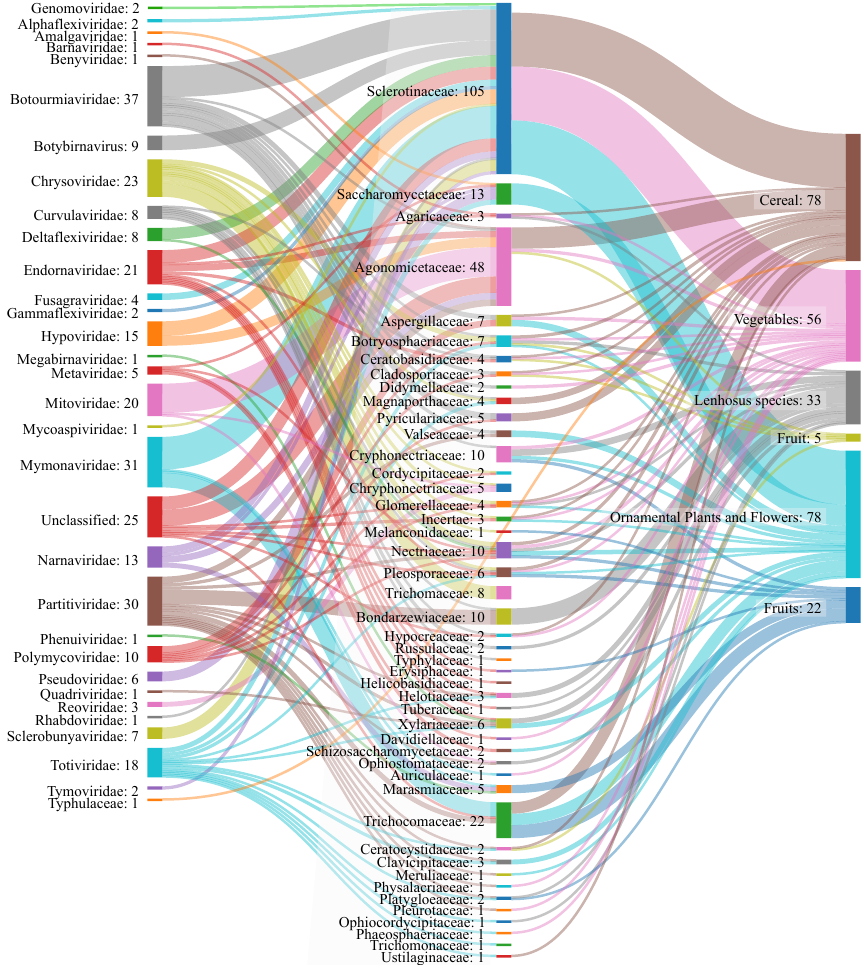
Figure 4. Outlook of the relationship between mycoviruses, fungi, and their plant hosts. The left column represents families of viruses that have been described as infecting fungi; the middle column indicates fungal families affected by these mycoviruses; the right column shows plant classes that are colonized by the fungal families. The information flow is represented by the thickness of the lines connecting the entries in the three